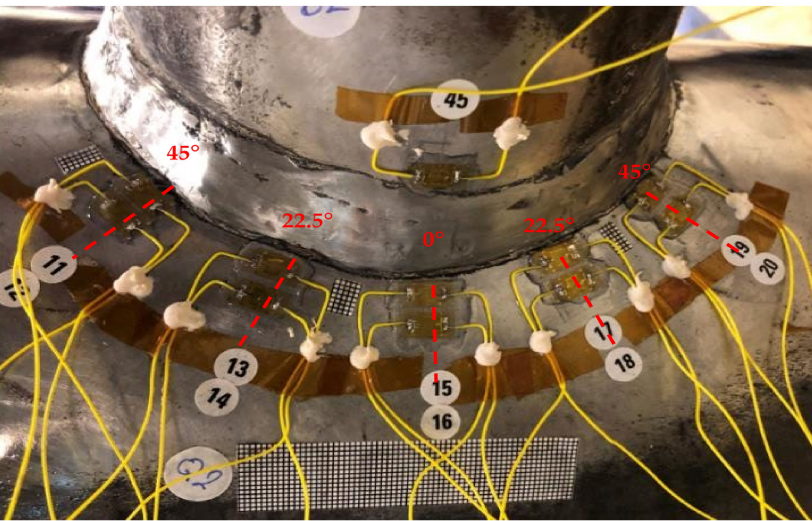
Figure 7. Chord saddle strain gauge